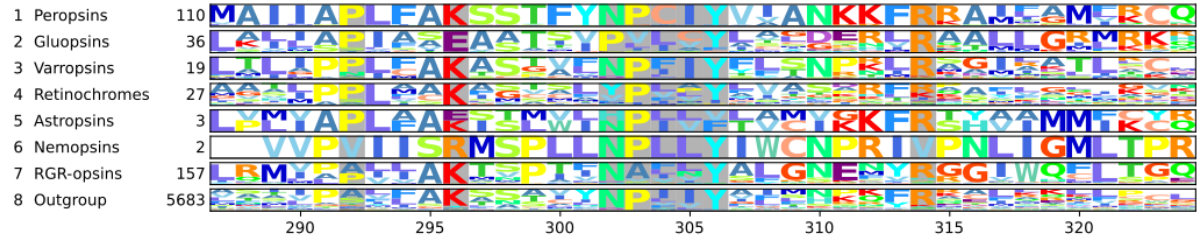
Figure 3. Consensus sequences of the different chromopsins. The first column contains a number for each chromopsin group for easy reference. The second column shows the names for each group. The groups are in the same order as in the tree in Figure 2C. The third contains the number of sequences in each group. And the fourth column contains the sequence logo, the height of the letters indicates the percentage of that amino acid given at that position. The x-axis gives the position of the amino acid corresponding to cattle rhodopsin. Positions 292 7.39 and 314 7.64 are highlighted in gray. Lysine (K) 296 7.43 is highlighted with a gray background, which is replaced in the nemopsins by arginine (R) and in the gluopsins by glutamic acid (E). The NPxxY 7.53 motif is highlighted with a gray background.